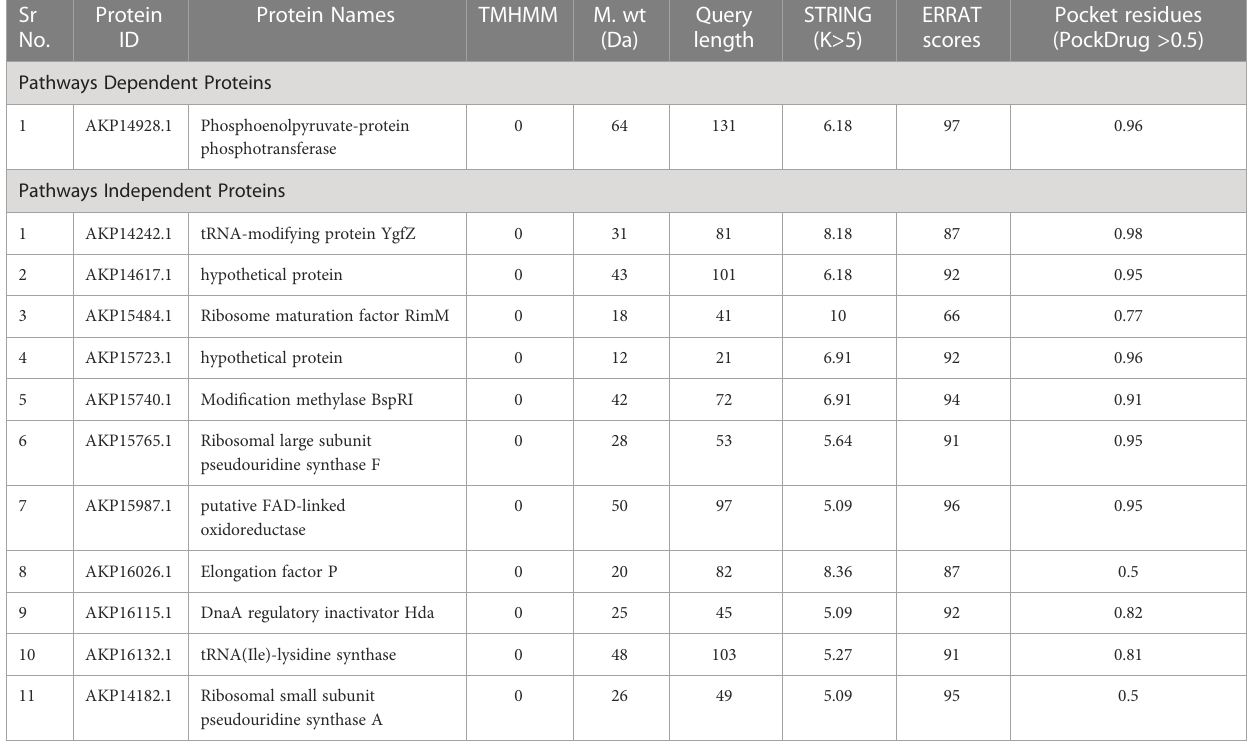
TABLE 2 Analysis of shortlisted druggable proteins. Sr